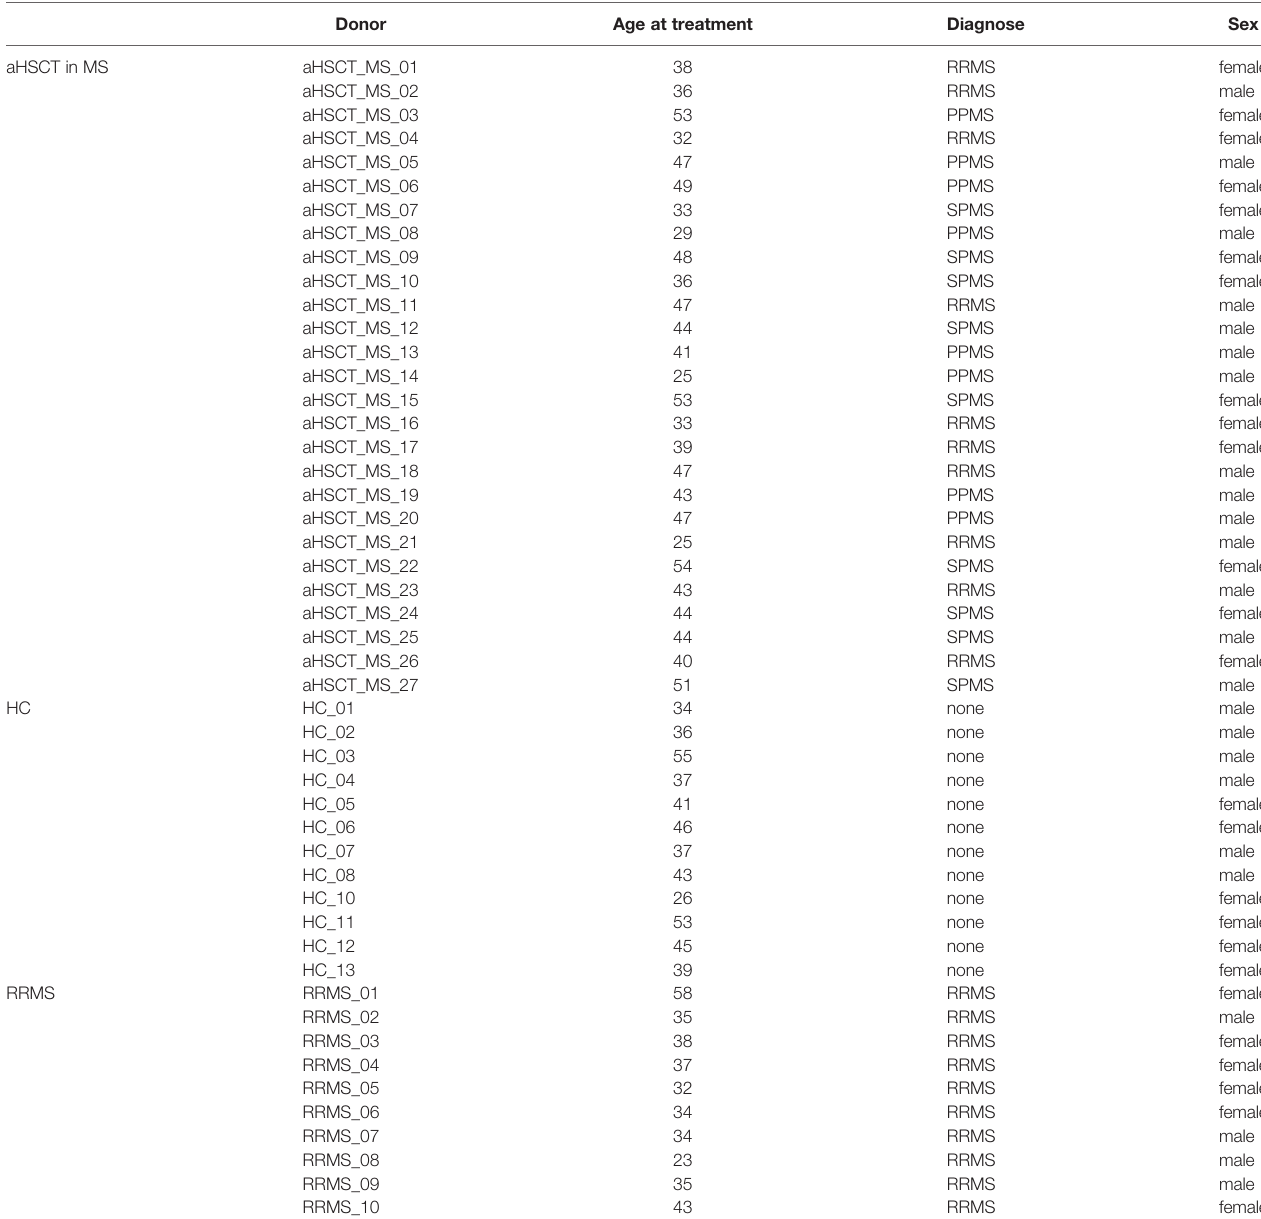
TABLE 1 | Clinical and demographic characteristics of MS patients treated with aHSCT as well as healthy controls and RRMS disease